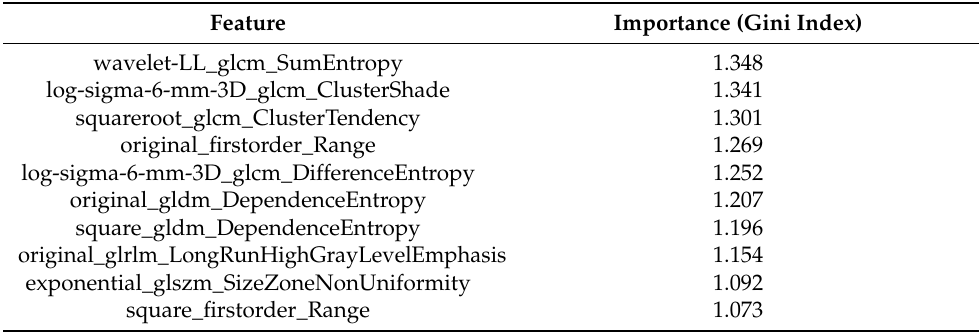
Table 2. Predicted importance of the top 10 radiomic features obtained from a random forest for prediction of response to therapy.